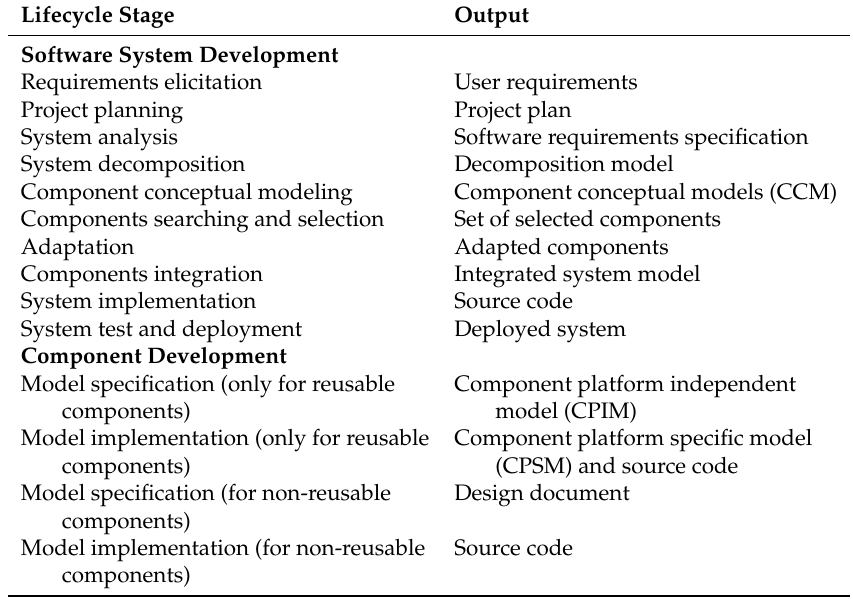
Table 2. The outputs of the CompoMDD process